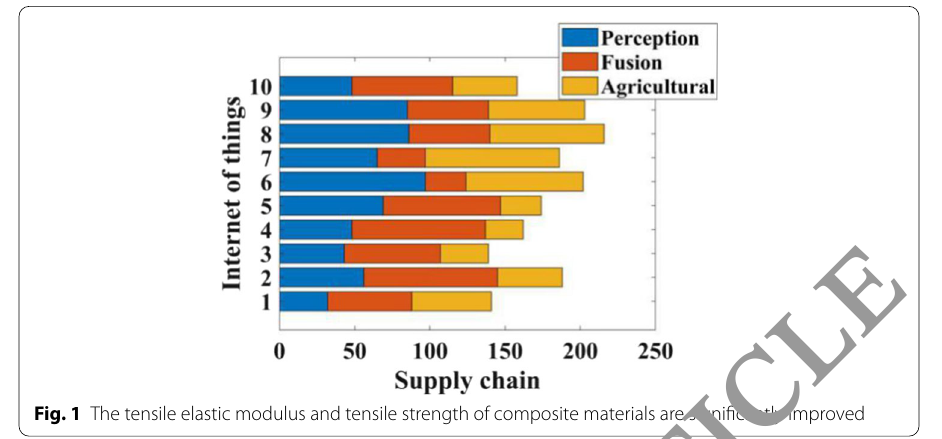
Fig. 1 The tensile elastic modulus and tensile strength of composite materials are significantly improved